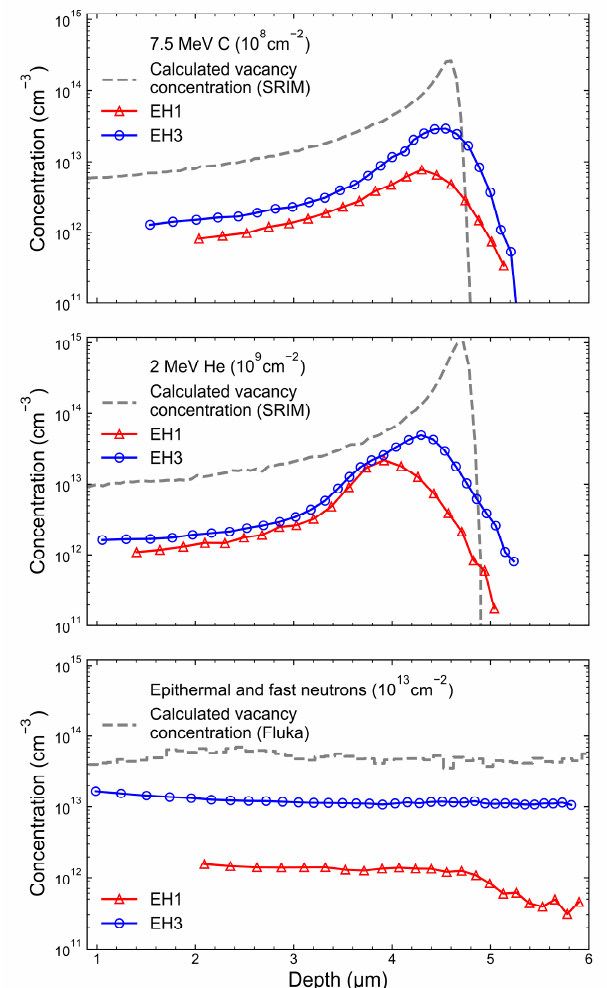
Figure 6. Depth concentration profiles for EH1 and EH3 deep levels and total introduced vacancies calculated by SRIM and Fluka software [42,47]. The lambda effect was taken into account [49]. Depth profiling measurements were carried out at the temperatures of 210 K and 350 K.